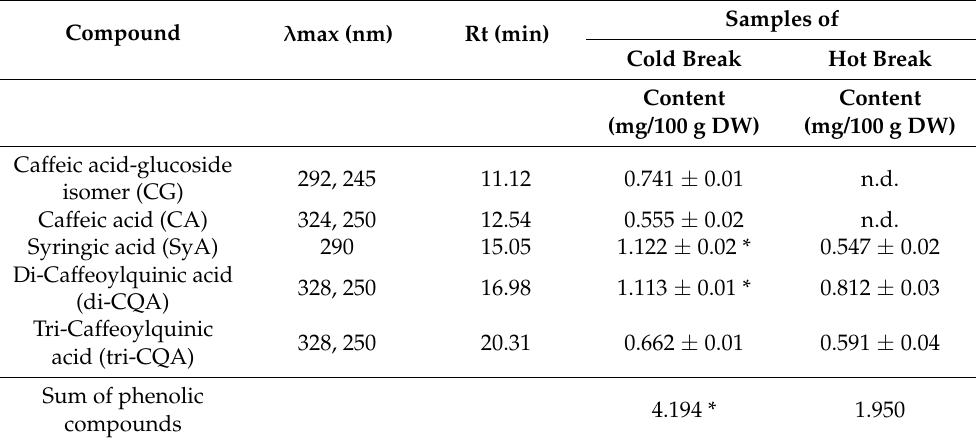
Table 5. Individual and sum of phenolic compounds of tomato seeds oils derived from cold break and hot break processing lines, expressed as mg chlorogenic acid equivalent/L oil; analytical mea- surements were conducted with three replicates ( n =